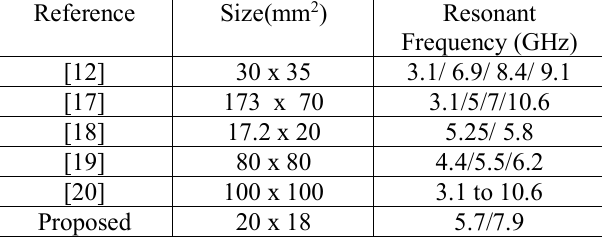
Table 5: Size comparison of proposed antenna